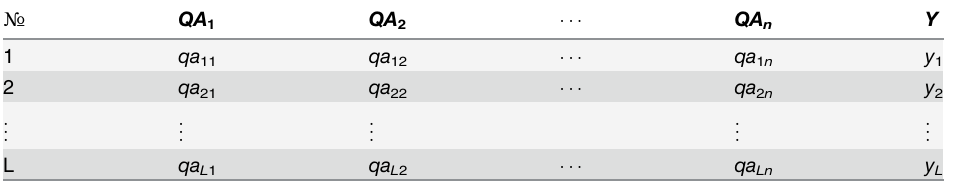
Table 1. Utility Function (2) in a form of a decision table. L is the number of elementary decision rules in the table. QA QA n Y № QA 1 2 (cid:2)(cid:2)(cid:2) 1 qa 11 qa 12 (cid:2)(cid:2)(cid:2) (cid:2)(cid:2)(cid:2) qa 2